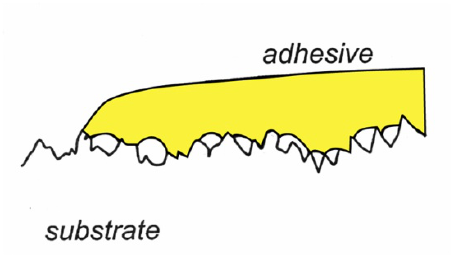
Figure 11. The adhesive placed on the substrate surface in this drawing does not wet the substrate surface. The reason could be unfavorable differences in surface tension properties of the adhesive and the substrate, or the presence of contaminants. The defects introduced will act as stress concentrators and increase the risk for catastrophic failure of the adhesive-substrate